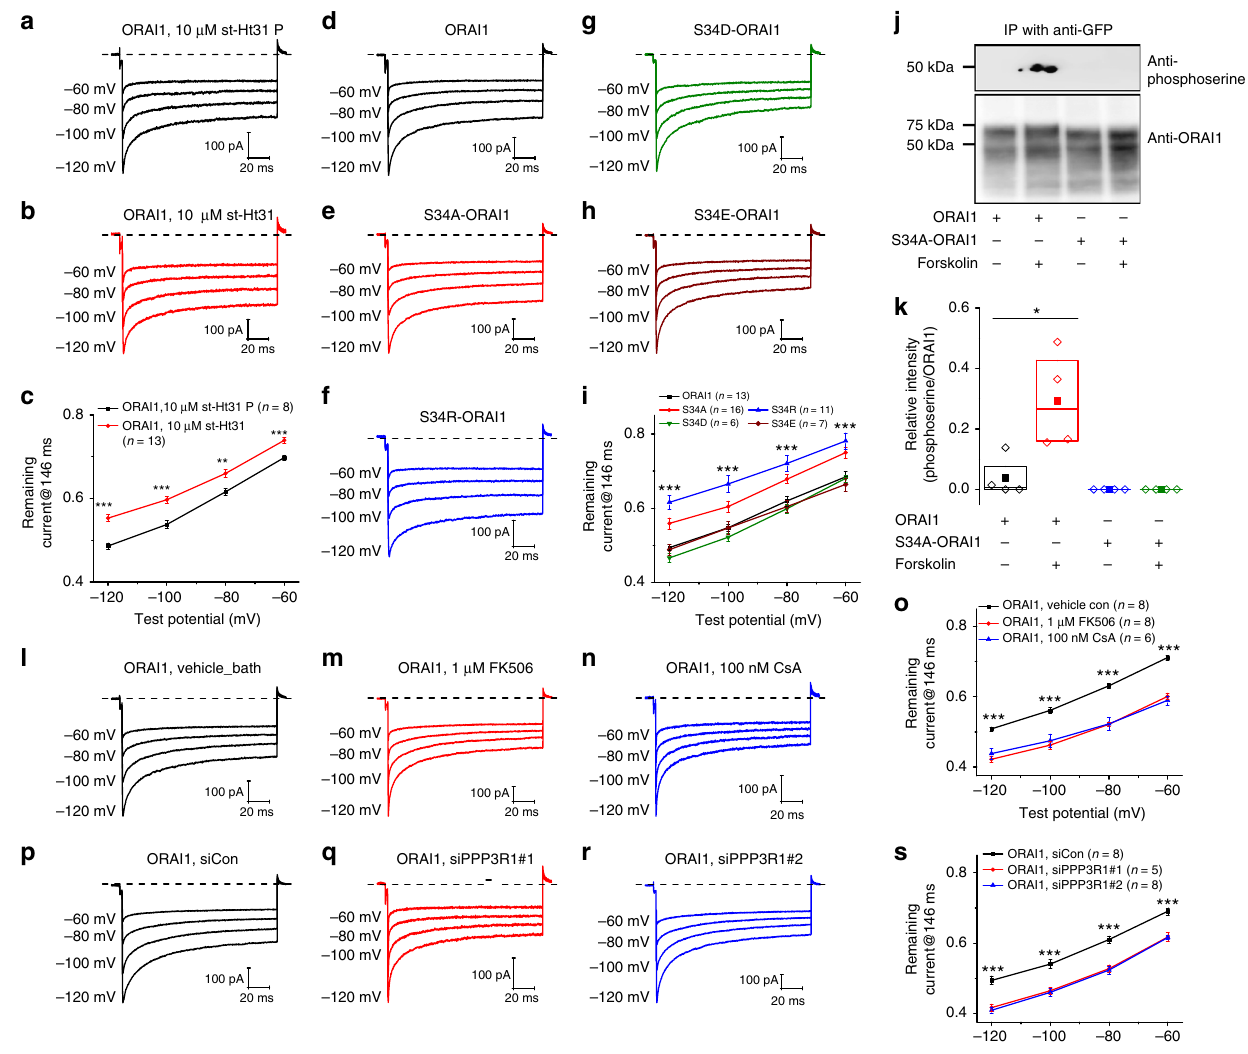
Fig. 4 PKA/AKAP79 and calcineurin reciprocally regulate ORAI1 CDI. a – c Representative currents from ORAI1-KO cells co-expressing eYFP-STIM1 with ORAI1-CFP and dialyzed through patch pipette with 10 µ M of either a the negative control st-Ht31 P peptide or b the st-Ht31 peptide. c The extent of ORAI1 CDI from ( a ) and ( b ) represented as current remaining at 146 ms. Each data point represents mean ± SEM. d – i Representative currents from ORAI1-KO cells co-expressing eYFP-STIM1 with either d wild-type ORAI1-CFP, e S34A ORAI1-CFP, f S34R ORAI1-CFP, g S34D ORAI1-CFP, or h S34E ORAI1-CFP. i The extent of CDI from all ORAI1 variants represented as current remaining at 146 ms. Each data point represents mean ± SEM. j Anti-phosphoserine western blots on immunoprecipitated wild-type ORAI1-eGFP and S34A ORAI1-eGFP from proteins extracts of ORAI1-KO cells co-expressing eYFP-STIM1 with and without stimulation with Forskolin (10 µ M). k Densitometry of phosphoserine/ORAI1 ratios from several independent experiments are shown as boxplots representing the 25th to 75th percentile range, mean and median. l – o Representative currents from ORAI1-KO cells co-expressing eYFP-STIM1 with ORAI1-CFP and treated in the bath with either l vehicle, m FK506 (1 µ M), or n cyclosporine A (CsA, 100 nM). o The extent of ORAI1 CDI from ( l ), ( m ), and ( n ) represented as current remaining at 146 ms. Each data point represents mean ± SEM. p – s Representative currents from ORAI1-KO cells co- expressing eYFP-STIM1 with ORAI1-CFP and co-transfected with either p a control non-targeting siRNA, or q , r two independent siRNA sequences against calcineurin regulatory subunit PPP3R1. s The extent of ORAI1 CDI from ( p ), ( q ), and ( r ) represented as current remaining at 146 ms. Each data point represents mean ± SEM. * p < 0.05, ** p < 0.01, *** p < 0.001, two-tailed Student ’ s t test was used for ( c , k ), and one-way ANOVA for ( i , o , s